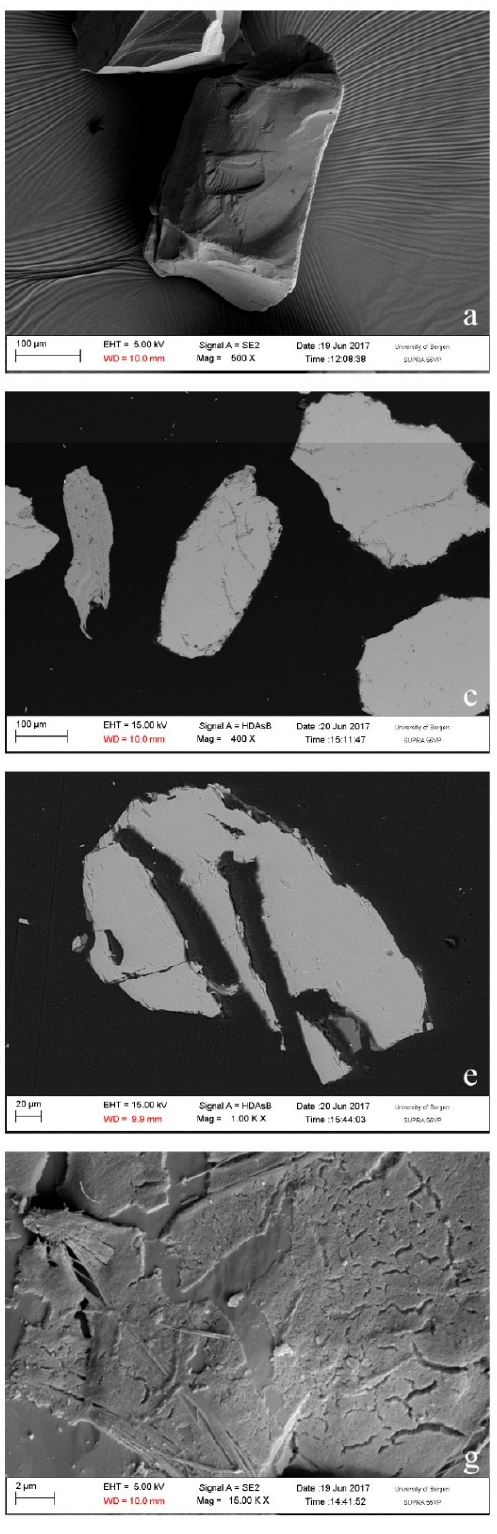
Figure 3. SEM micrographs of unreacted ( a – c ) and reacted ( d – h ) Åheim dunite grains. Both loose grains ( a , b , d , f – h ) and polished sections ( c , e ) are shown. In ( d , e ), note the deep channels caused by dissolution. In ( f ), note the crystallographically controlled etch pits. Finally, ( e , g ) show thin layers on grain surfaces, which were most likely formed by precipitation.